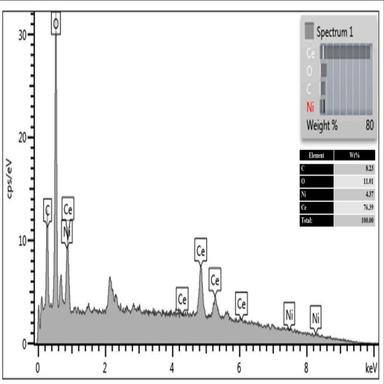
Elemental mapping analyses of NiCeO2@f-MWCNT/EDA.